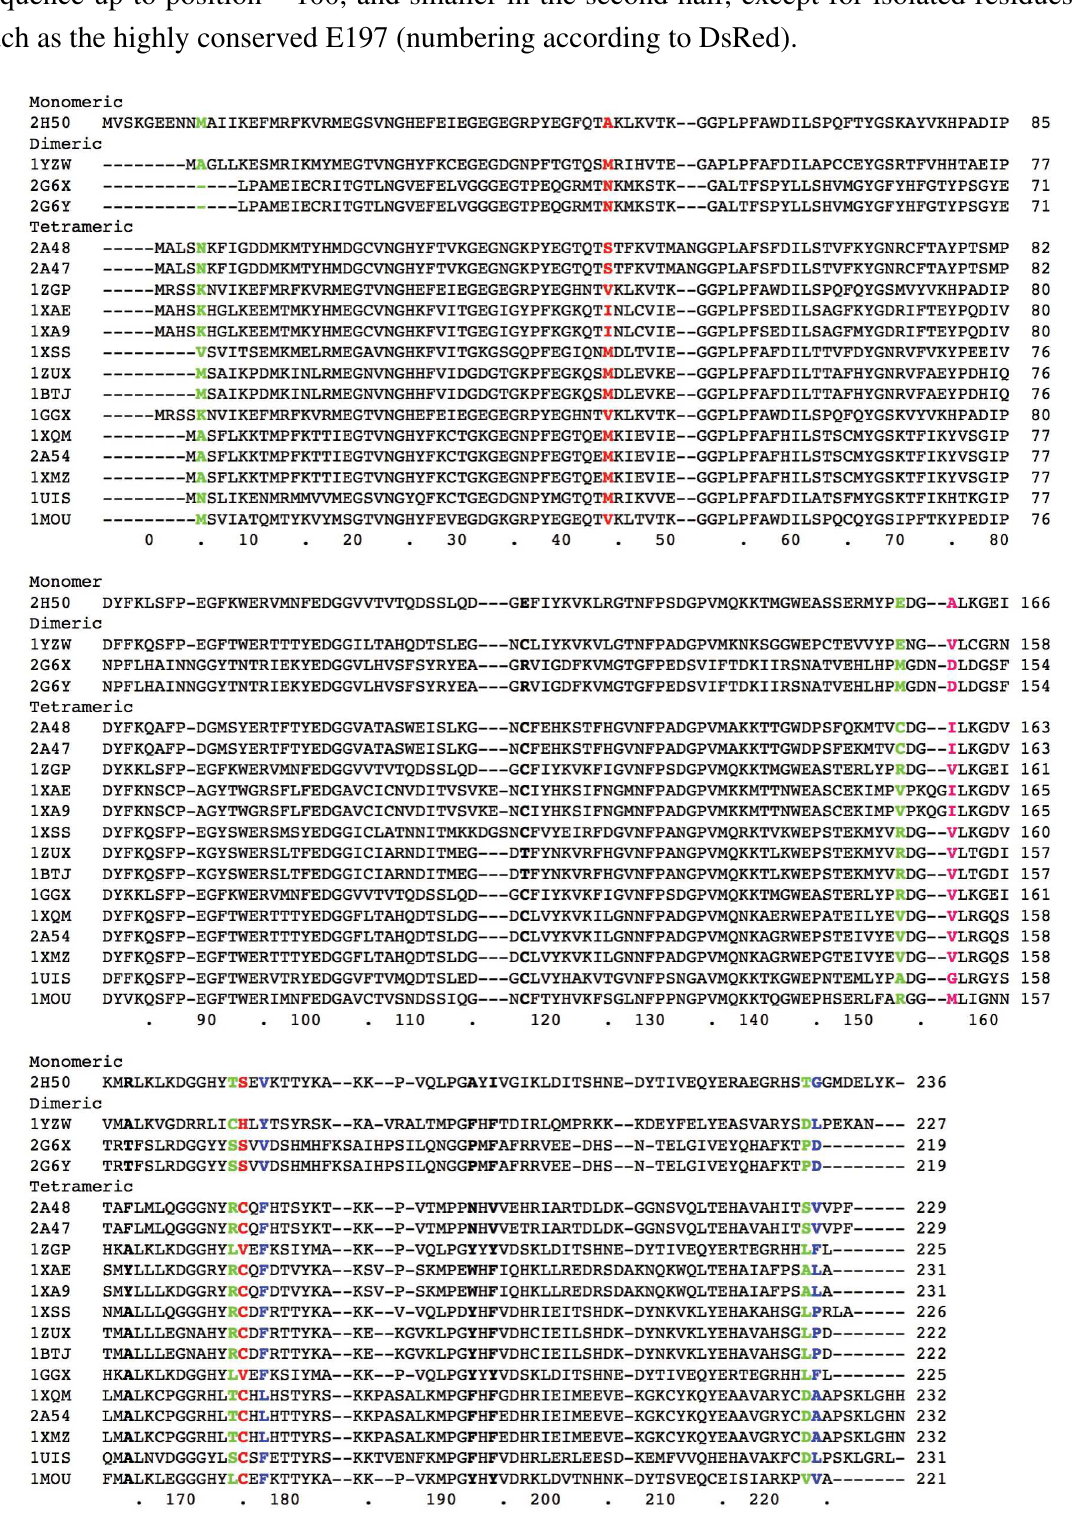
Figure 2. Alignment of a subset of 18 crystallized IFPs, labeled according to their pdb code. The sequences are separated according to their multimeric class and amino acids in specific positions colored as in Table 6 (complete alignment given in the SI). The whole IFP set has an overall average identity of 40 . 8% . The sequence identity is larger in the first part of the sequence up to position ∼ 100, and smaller in the second half, except for isolated residues such as the highly conserved E197 (numbering according to